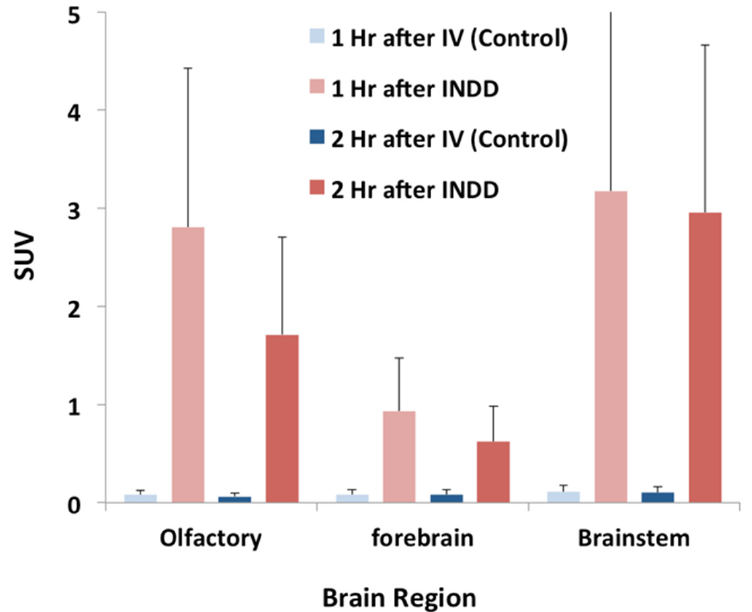
Figure 7. Brain region activity at 1 and 2 h following INDD of 100 nm PLA–polyethylene gly-